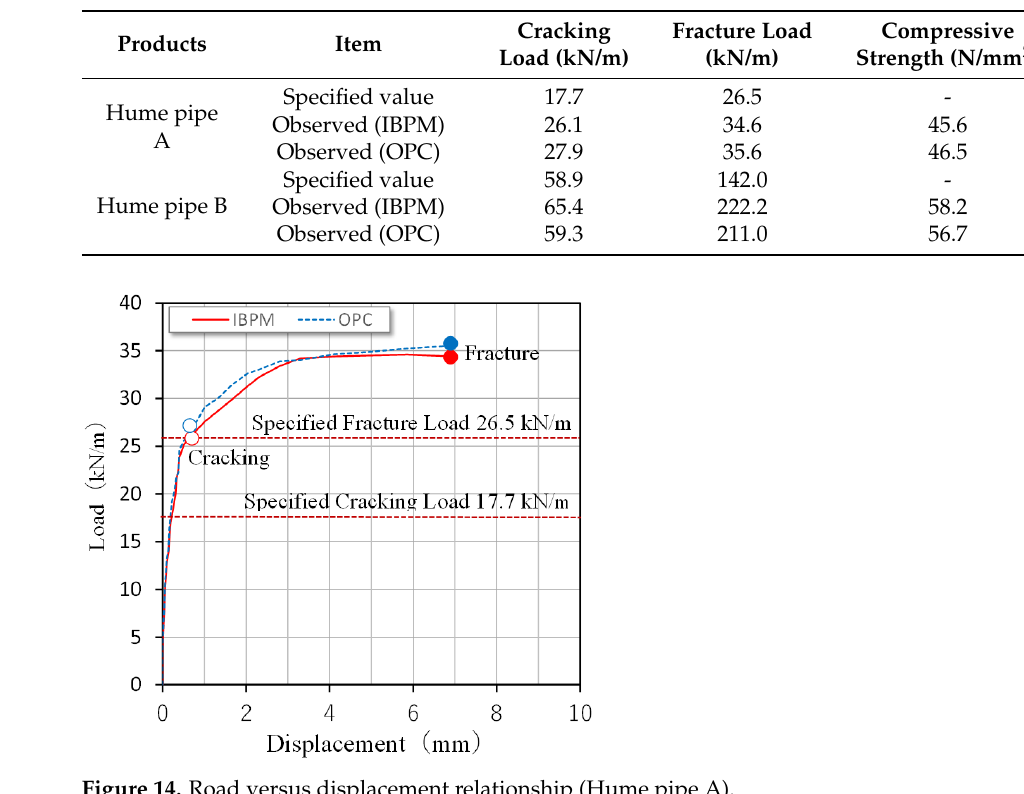
Table 9. Load-bearing capacities of Hume pipe specimens and compressive concrete strengths.